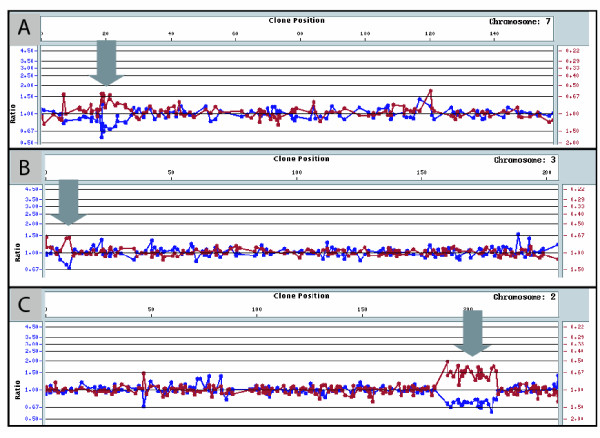
Genomic microarrays reveal chromosomal microdeletions. Genomic microarrays containing 2,600 BAC probes were used to assess microdeletions. The y-axis indicates ratio of patient to control signal and (in a dye swap paradigm) control to patient signal. The x-axis indicates physical map position (units in Mb). Panel A: case L99-2287 (chromosome 7 microdeletion in facial dysgenesis). Panel B: case L99-2297 (chromosome 3p deletion syndrome). Panel C: case L99-2287 (deletion of chromosome 2 including CPS I deficiency). Arrows indicate region of deletion. The plots were generated using SpectralWare (Spectral Genomics) software.